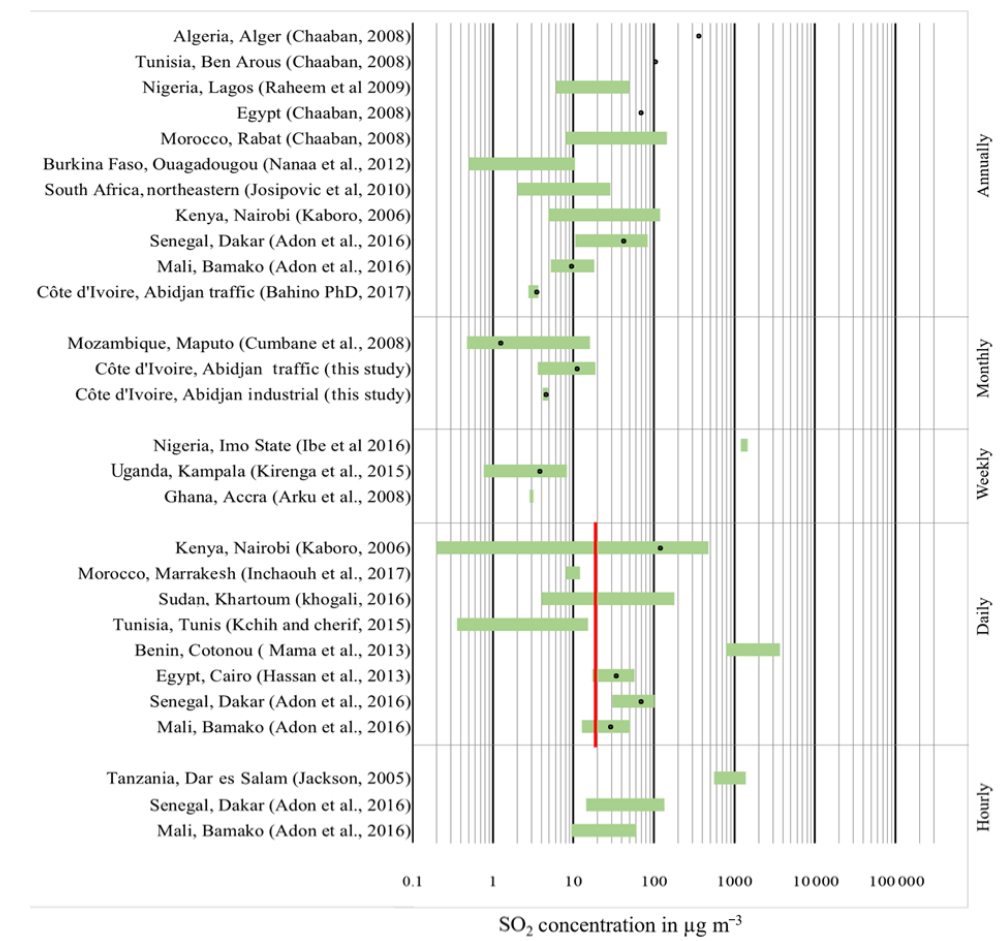
Figure 15. SO 2 concentration levels in µgm − 3 in African capitals at different timescales (hourly, daily, weekly, monthly and annually) as reported in literature. Green bars represent lower and upper range of means if reported. Black points represent average concentration of SO 2 . Red vertical lines illustrate current WHO guidelines at different